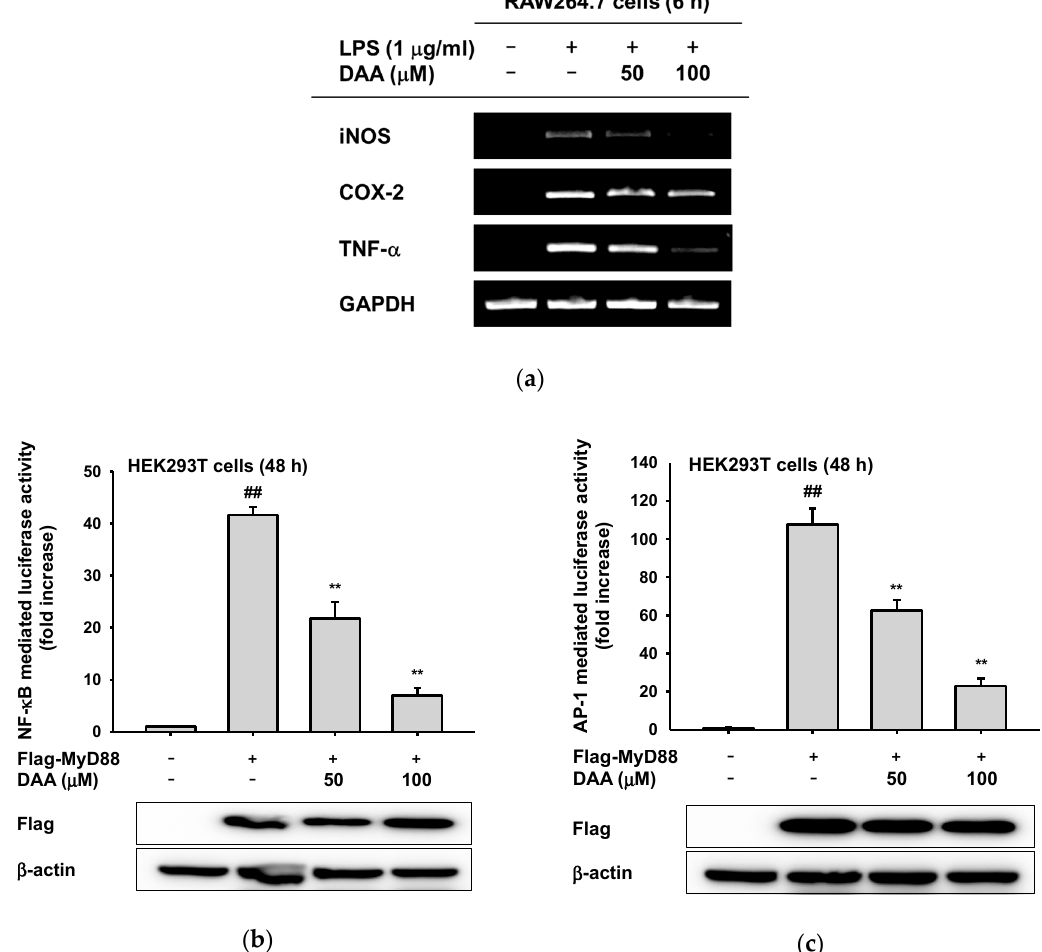
Figure 3. Effect of DAA on inflammatory transcriptional activation. ( a ) RAW264.7 cells were incubated with DAA (0–100 µM) in the presence or absence of LPS (1 µg/mL) for 6 h. Total mRNA was prepared from cells using Trizol methods, described in the Materials and Methods section. mRNA levels of inducible nitric oxide (iNOS), cyclooxygenase (COX)-2, and tumor necrosis factor (TNF)- α were determined by semiquantitative PCR. ( b,c ) Flag-MyD88 was transfected into HEK293T cells using polyethylenimine (PEI) with nuclear factor (NF)- κ B-Luc or activator protein (AP)-1-Luc constructs, respectively. β -galactosidase plasmid was used as a control. DAA was treated for an additional 24 h, and luciferase activity was measured by a luminometer. The expression level of Flag-MyD88 (Lower panels of b and c ) was examined by Western blotting. Antibodies against Flag and β -actin were used. Relative intensity ( b , c ) was values of the ratios calculated using densitometric scanning values of tagging protein (Flag) and densitometric scanning values of β -actin by the DNR Bio-imaging system (Gelquant software Version 2.7). ## p < 0.01 compared to the normal group, ** p < 0.01 compared to the induced group.